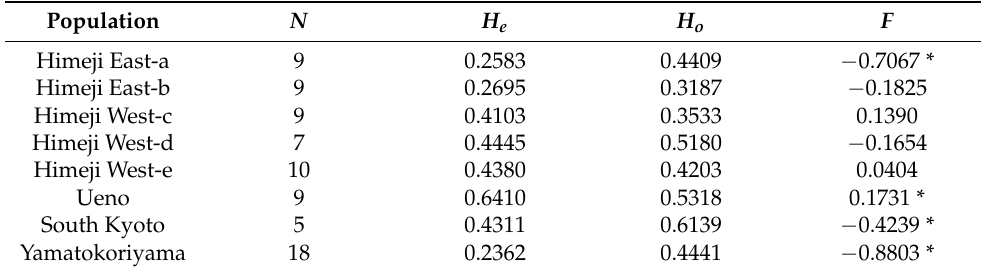
Table 1. Heterozygosity of each population.